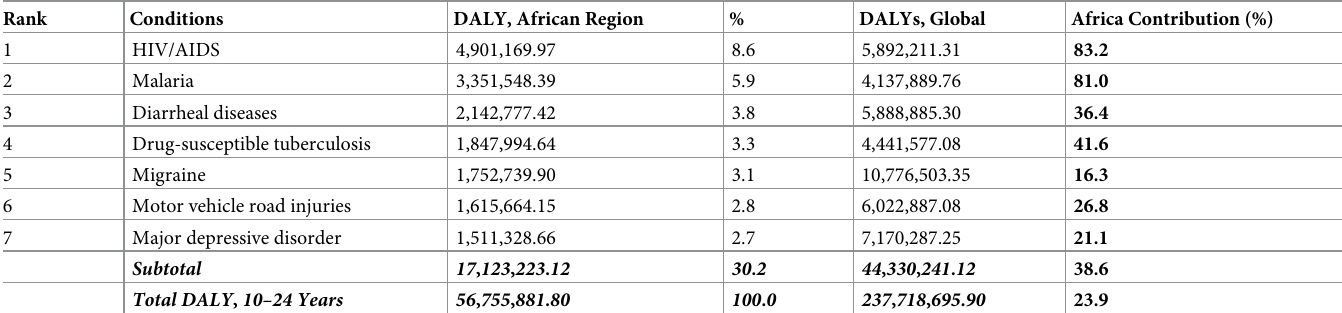
Table 6. Leading conditions in 10–24 age cohort in the Africa region, global and African region DALY contribution,